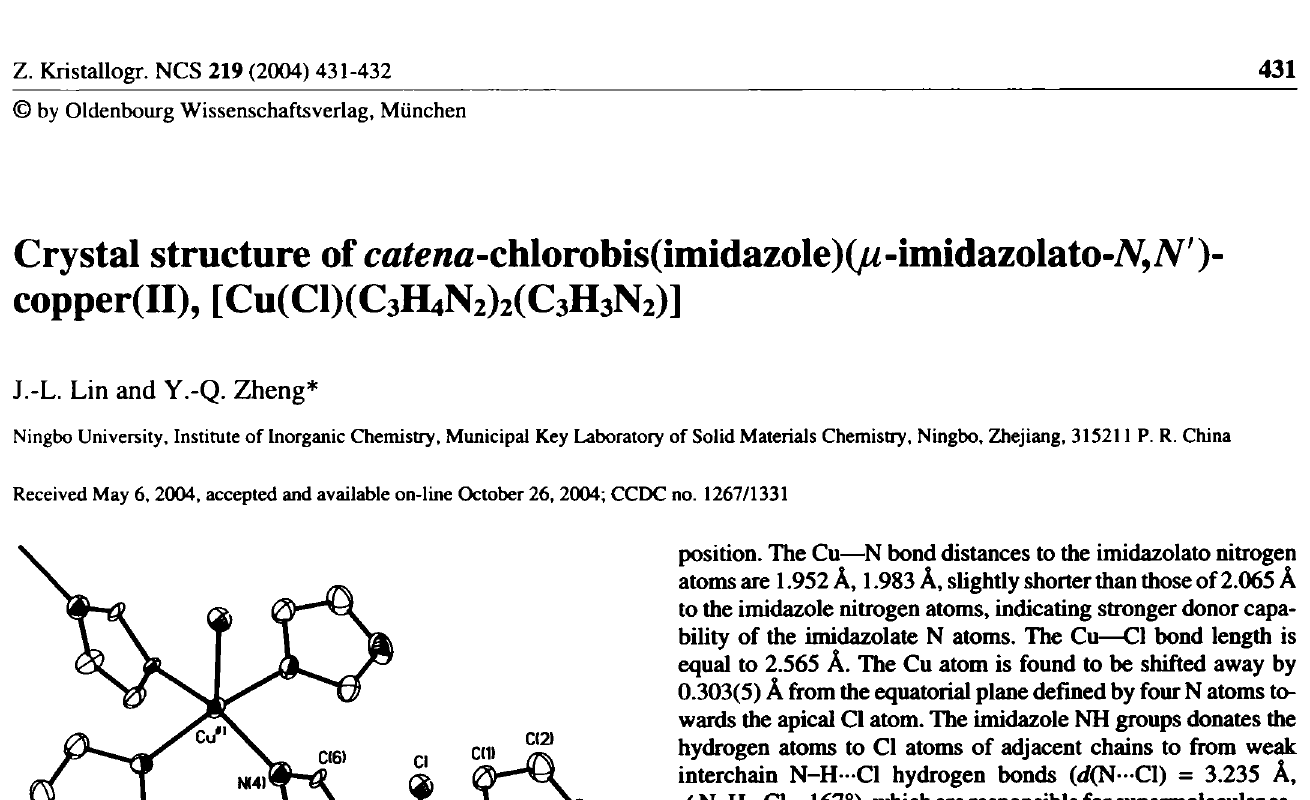
Table 1. Data collection and handling.